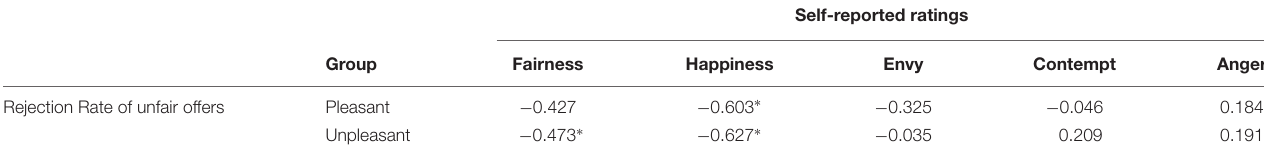
TABLE 1 | Correlation coefficients between self-reported ratings and rejection